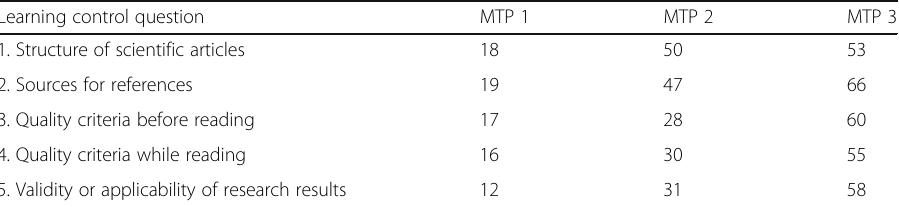
Table 4 Development of the average coverage of the model solution concepts at different measurement times (MZP) for the control group Learning control